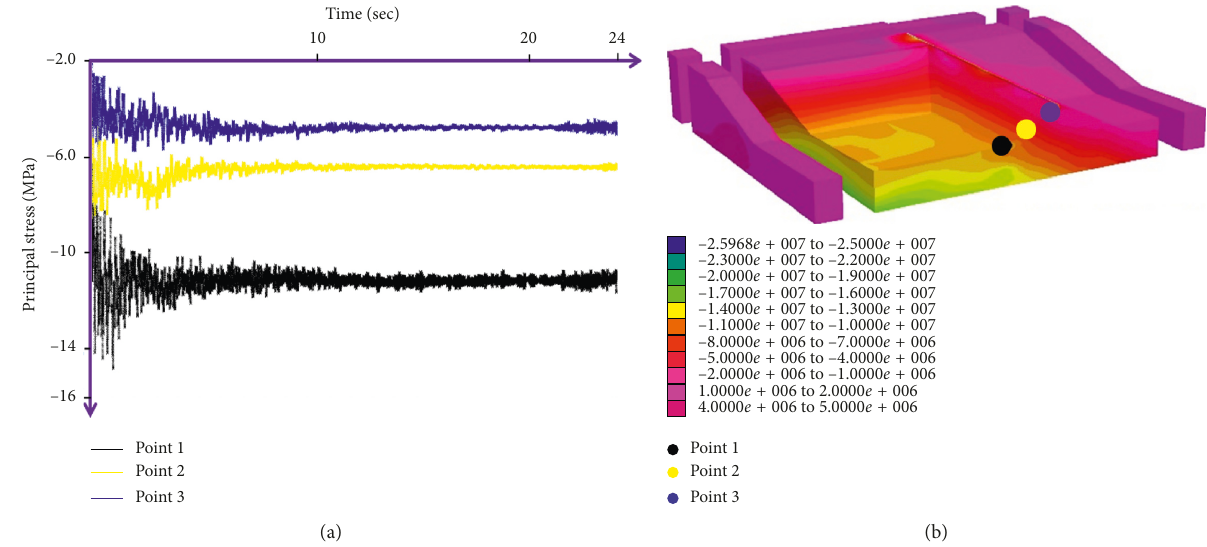
Figure 21: (a) Principal stress-time graphic for the Morgan earthquake. (b) Contour plot diagram for 24 th second of the Morgan